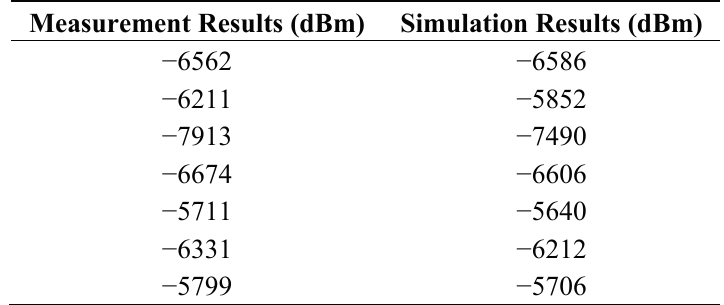
Table 4. Comparison between RSSI and simulation power